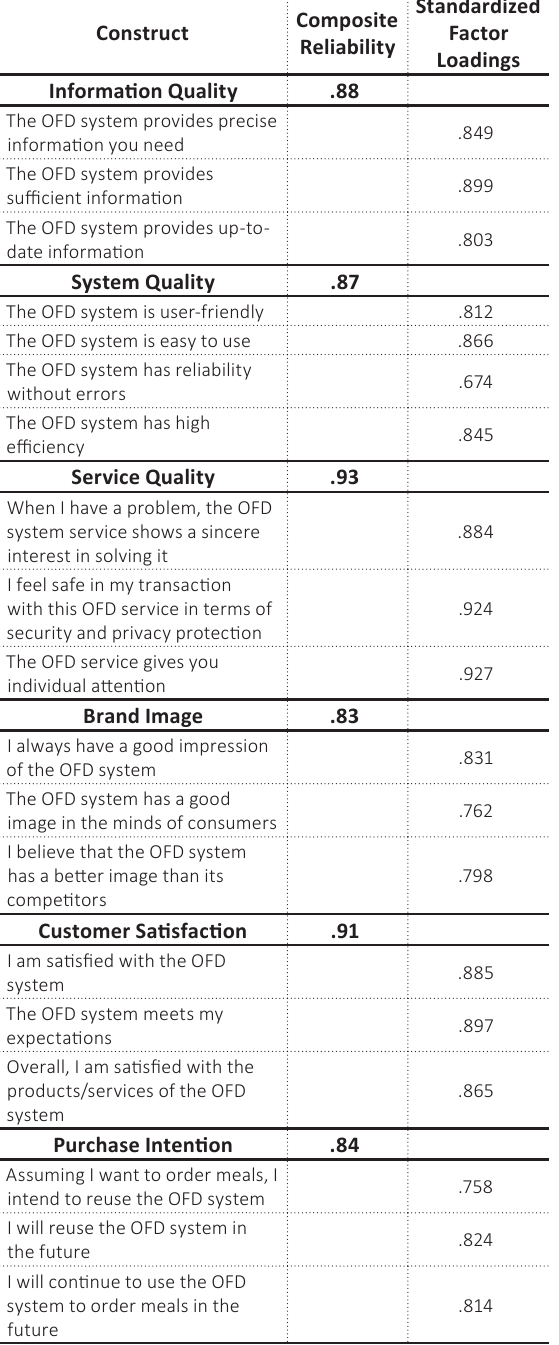
Table 3. Measurement model